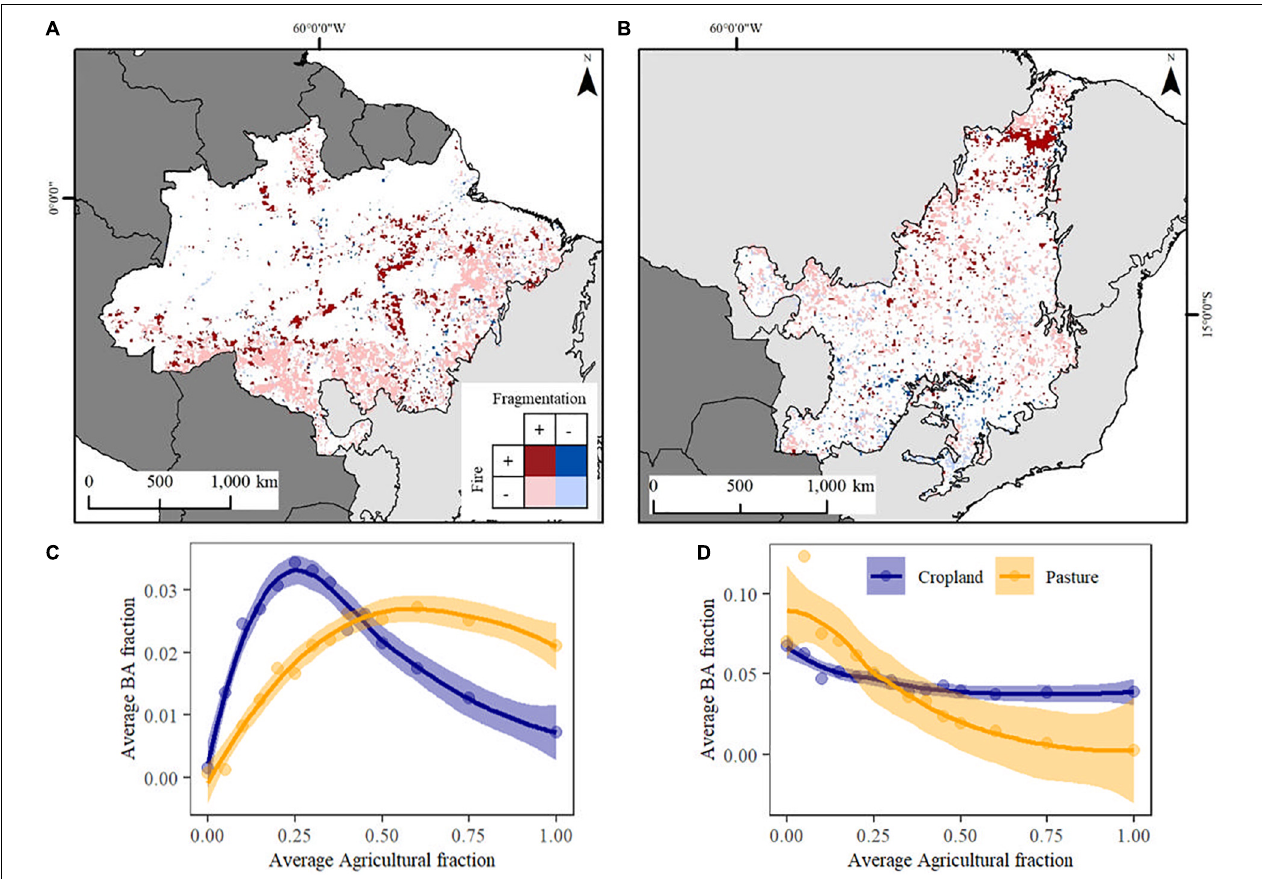
FIGURE 5 | Pixel-based integration of the fragmentation and BA fraction trends ( p < 0.05) between 2002 and 2018 for (A) Amazonia and (B) Cerrado. Non-significant pixels and pixels with no BA data are shown in white inside the biome boundaries; (C) Amazonia average BA fraction according to thresholds of agricultural fraction within grid-cells (i.e., Cropland and Pasture); (D) Cerrado average BA fraction according to thresholds of agricultural fraction within grid-cells (i.e., Cropland and Pasture). The relationship between BA fraction and agriculture was fitted with a LOESS regression. Note that the average scale for panels (C,D) are not the same due to the different scale of BA in each biome. A histogram frequency of each category of panels (A,B) maps is on Supplementary Figure 3